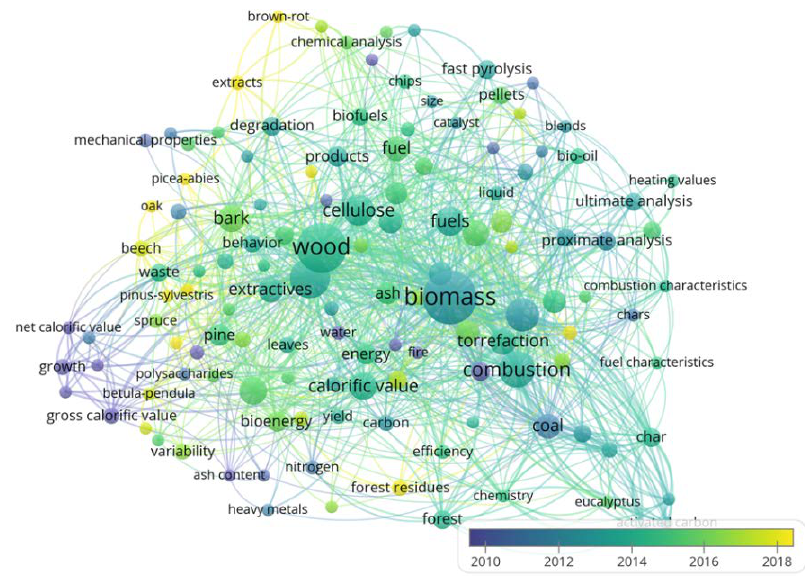
Figure 4. Network visualisation of papers selected for analysis.